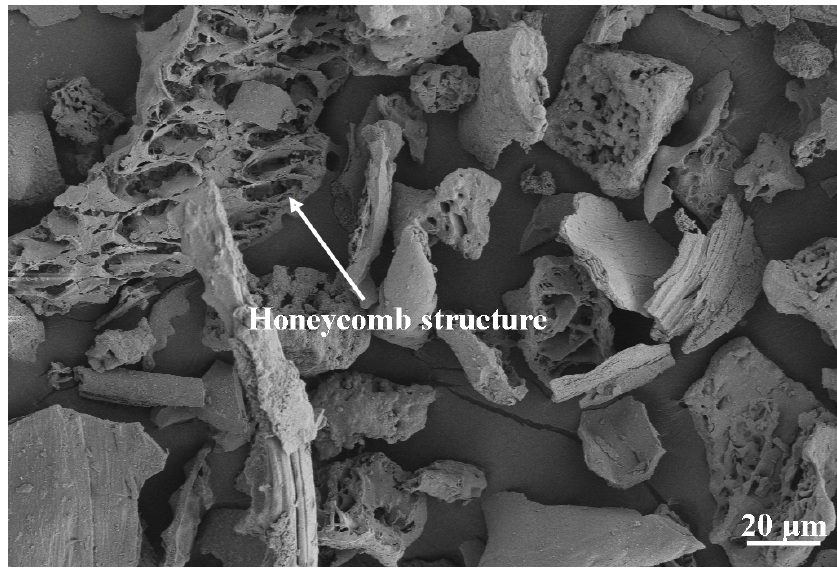
Figure 1. Microstructure of RHA measured by scanning electron microscopy. Table 1. The physicochemical characteristics of the cementitious materials